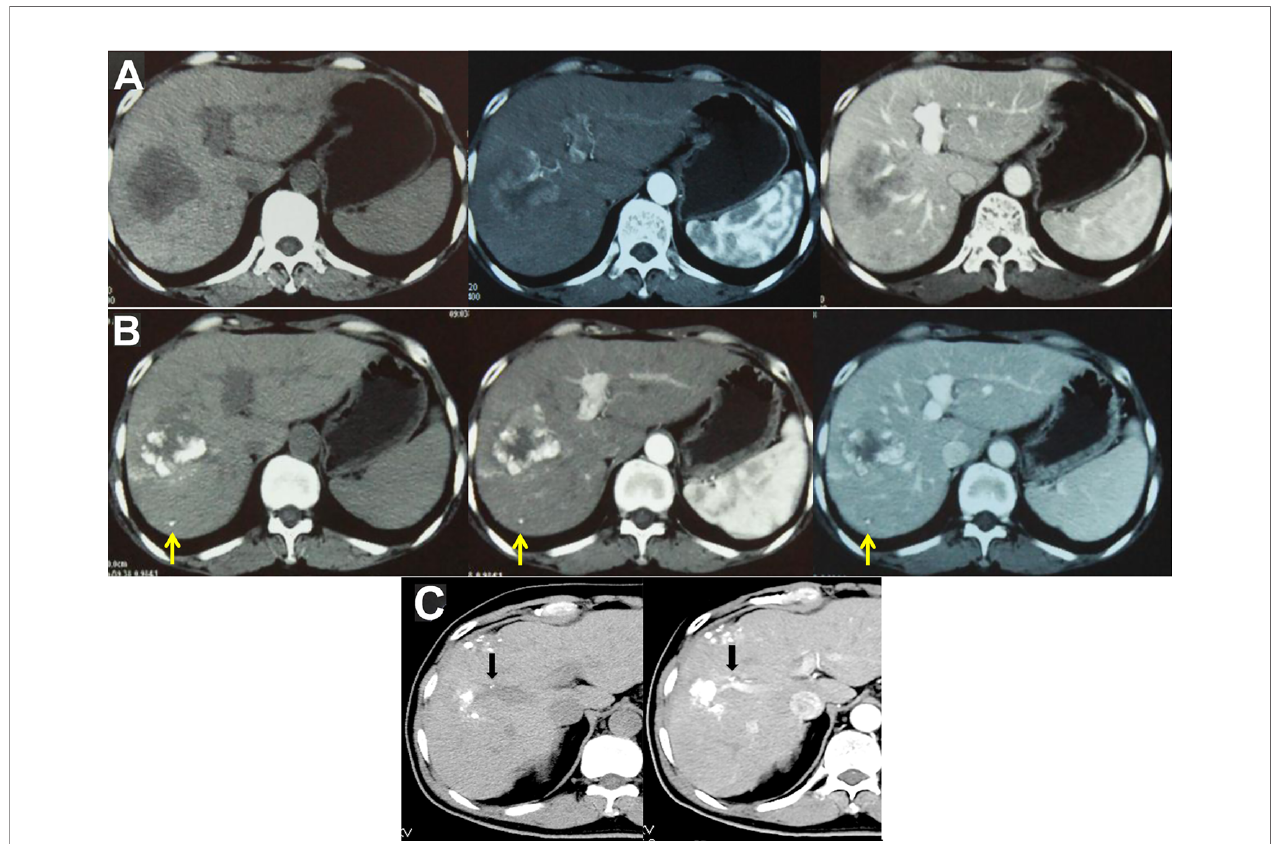
FIGURE 4 | TACE-CT enables detection of focal loci and precise staging. (A) CT before treatment showed a 7-cm tumor in the S5 and S6 region of the liver; (B) Follow-up CT examination at 4 weeks after TACE showed that the tumor volume at S5 and S6 was reduced, while a small lesion was detected at S6, as indicated by the arrow; (C) In another male patient, follow-up CT examination at 3 weeks after TACE showed intravascular lipiodol deposits (indicated by the arrow), suggesting the formation of an intravascular small tumor